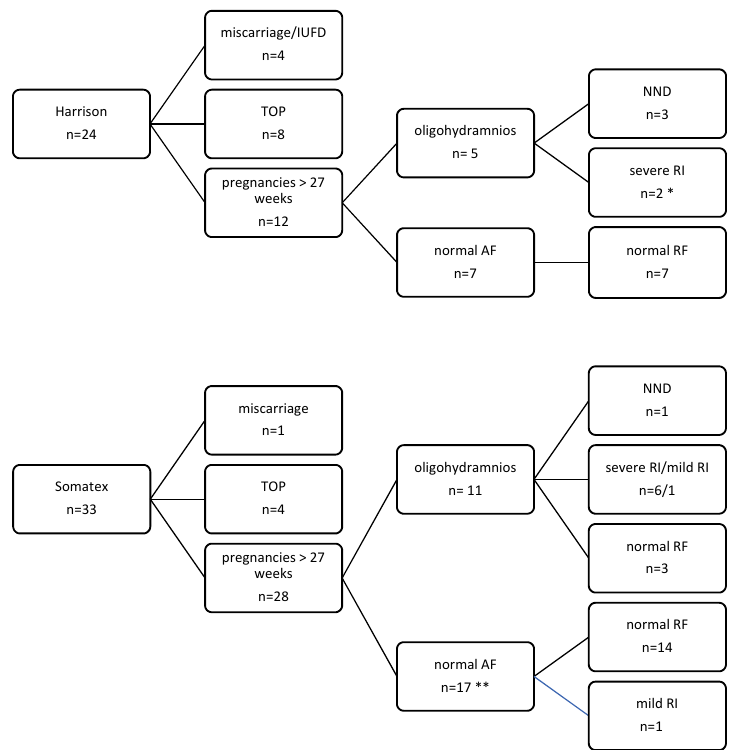
Figure 2. Outcome of pregnancies according to type of shunt. * 1 died during follow-up; ** 2 lost to follow up. AF (amniotic fluid); IUFD (intrauterine fetal death); NND (neonatal death); RI (renal impairment); RF (renal function); TOP (termination of pregnancy).